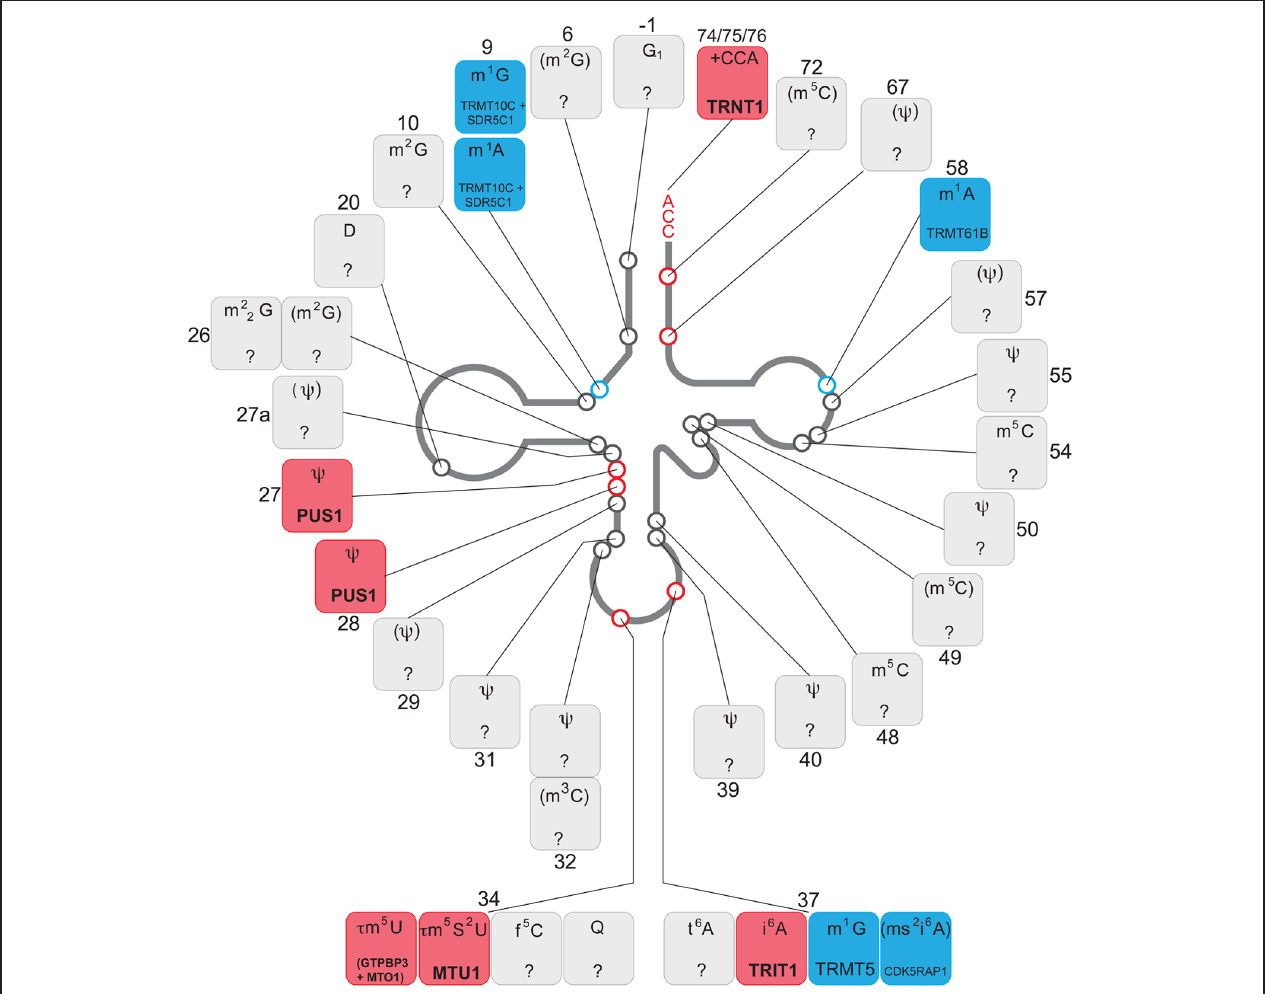
FIGURE 2 | Chemical modifications of mitochondrial tRNA. Schematics of the “clover leaf” secondary structure of a generic mitochondrial tRNA indicating post-transcriptionally modified bases (circles). The details of the chemical modification and enzyme responsible (if known) for each tRNA position is given in boxes, indicating a tRNA base position number next to each box. The